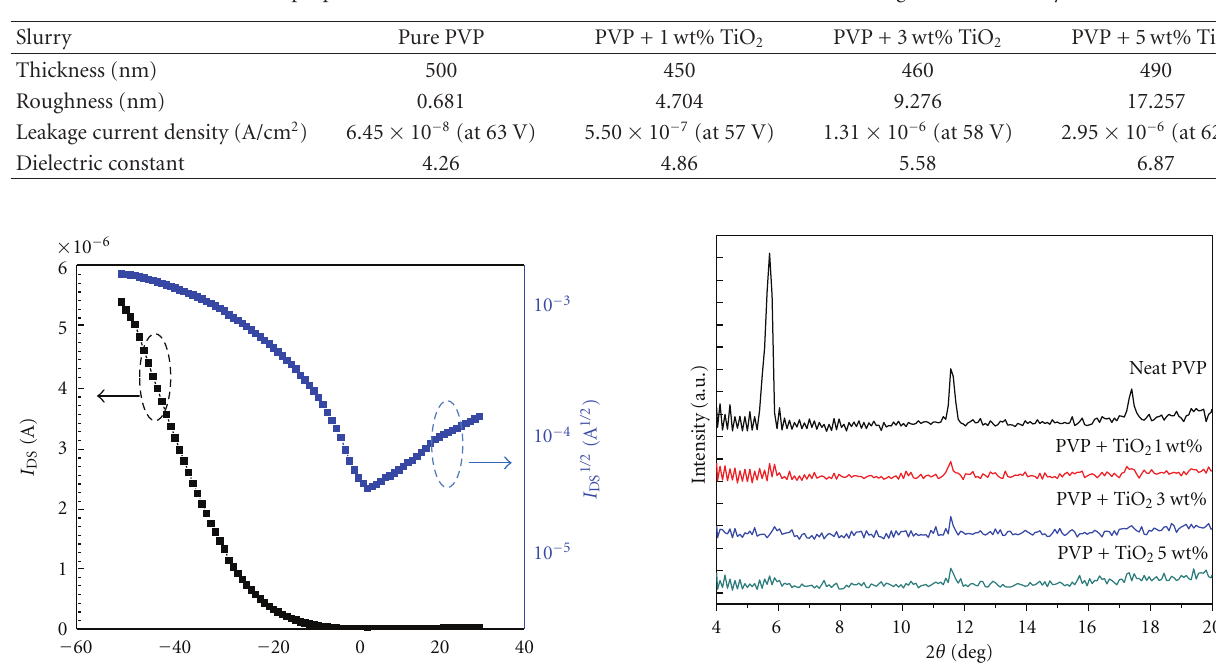
Table 1: The properties of MIM with PVP insulators with di ff erent TiO 2 -blending concentration by IJP.